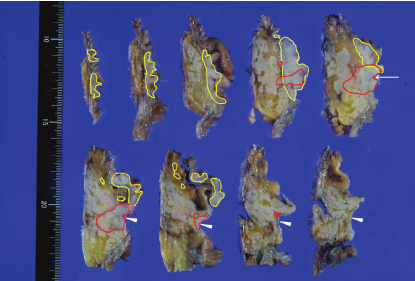
Figure 4: Cross-sections of the resected specimen. The tumor is composed of follicular lymphoma (enclosed by curved yellow line) and adenocarcinoma (enclosed by curved red line) of the ampulla of Vater (arrow). Adenocarcinoma includes the lower part of the common bile duct